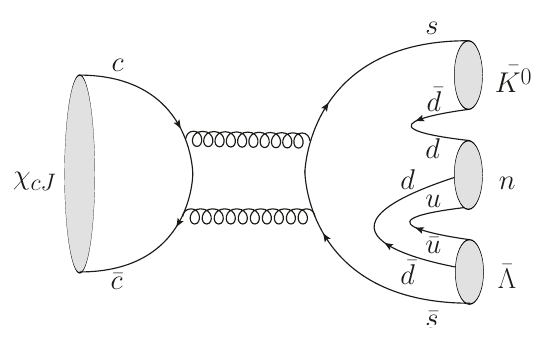
¯Λ decay, where J = 0 , 1, and S